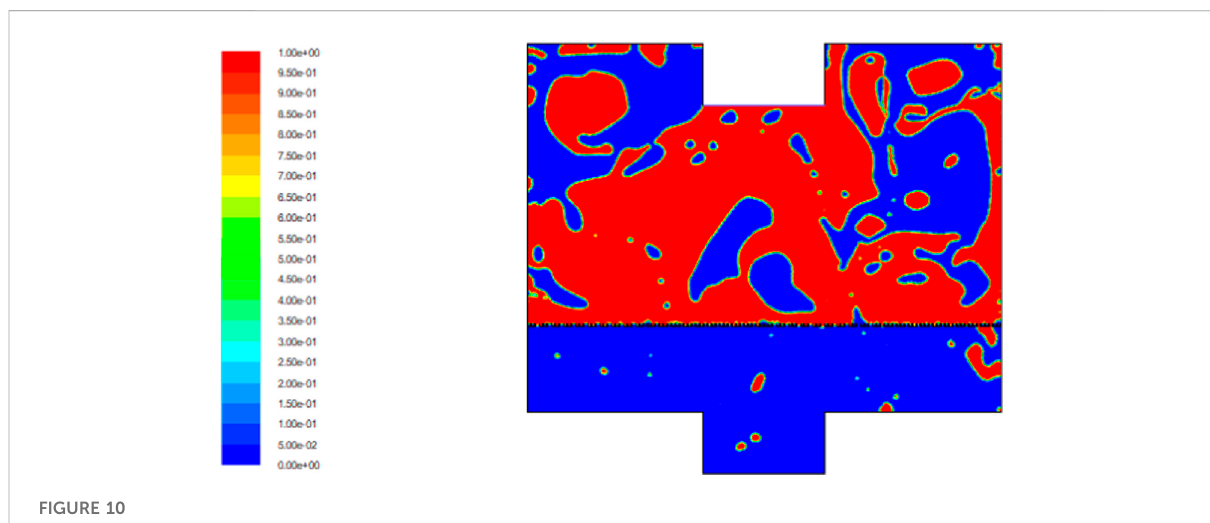
FIGURE 10 Cloud picture of the oil-phase volume fraction.